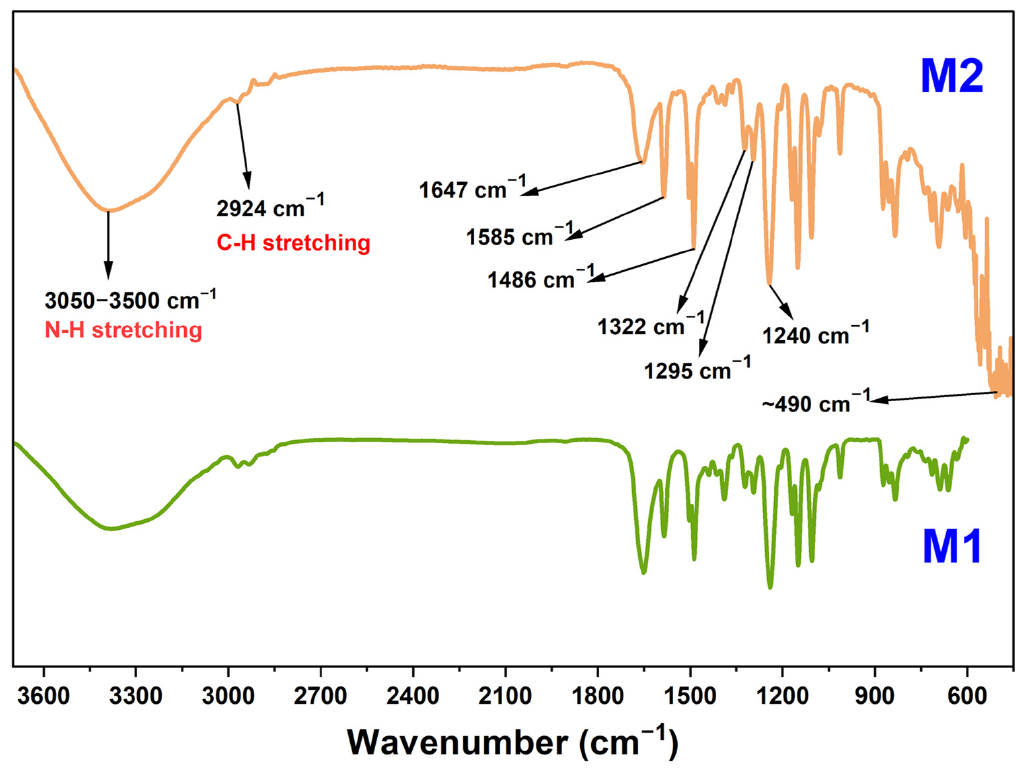
Figure 5. ATR-FTIR spectra of prepared M1 and M2 membrane.